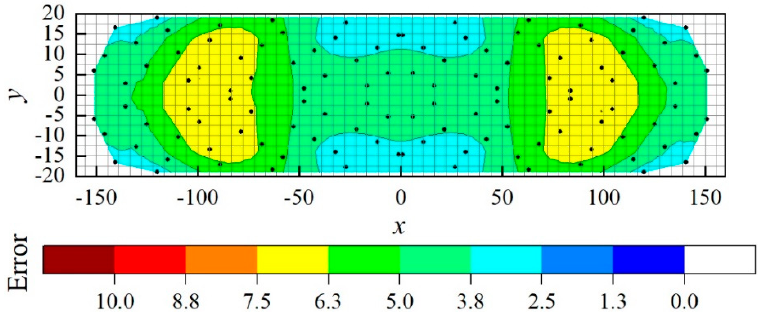
Figure 11. Error contour of contact pressure prediction on the gas diffusion layer (GDL).